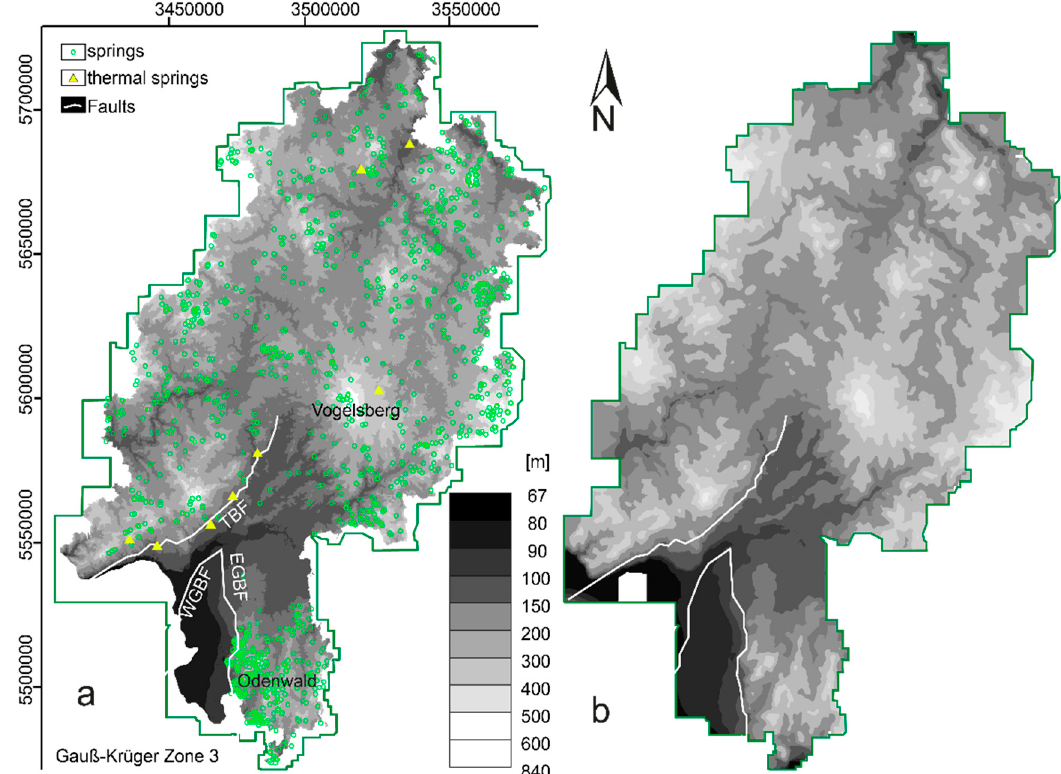
Figure A2. ( a ) Groundwater surface based on the model by Herrmann [18]. Locations of springs (green circles) and thermal springs (yellow triangles) in Hesse (data from HLNUG). ( b ) Groundwater surface used as the upper hydraulic boundary condition. White lines indicate the surface geometry of the three main faults in the model area.